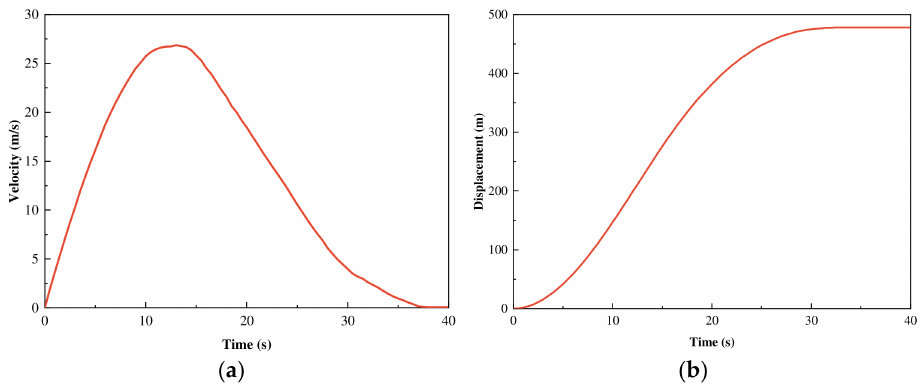
Figure 13. Average ( a ) sliding velocity and ( b ) sliding displacement of the accumulation